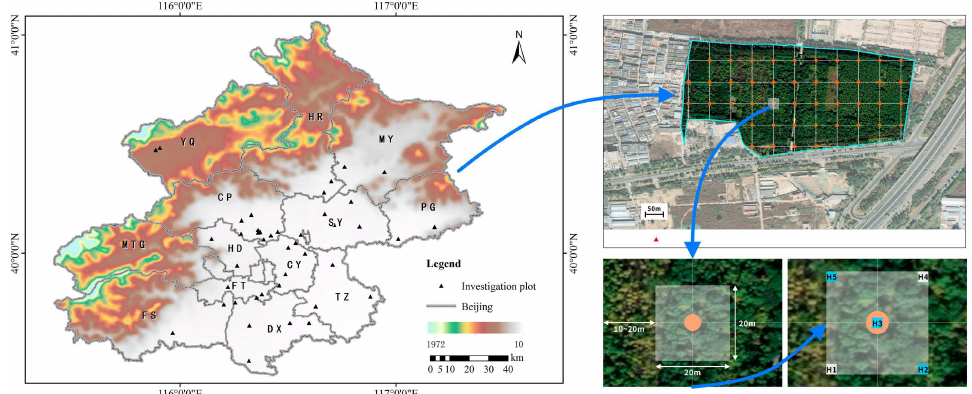
Figure 2. Sample plots for plant and soil collection. Note: In the figure, H1–H5 are the survey sample points for understory plants; H2, H3, and H5 are soil sampling